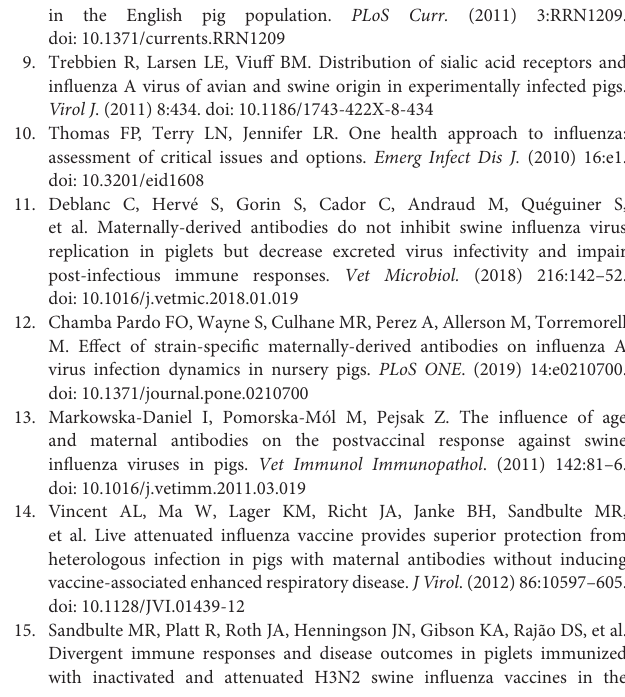
Supplementary Figure 1 | Experimental pig groups had the influenza virus specific maternal IgG antibody in the serum. Pregnant sows were vaccinated with commercial influenza vaccine at 2 and 5 weeks before farrowing. Serum collected from weaned piglets at 3 weeks of age was serial 10-fold diluted and analyzed for the H1N2-OH10 virus specific IgG antibody level. Data represent the mean value of three to four pigs ± SEM at all indicated dilutions. Statistical analysis was carried out using one-way ANOVA followed by Tukey’s post hoc comparison test. Supplementary Table 1 | Sequence of the primers used in qRT-PCR